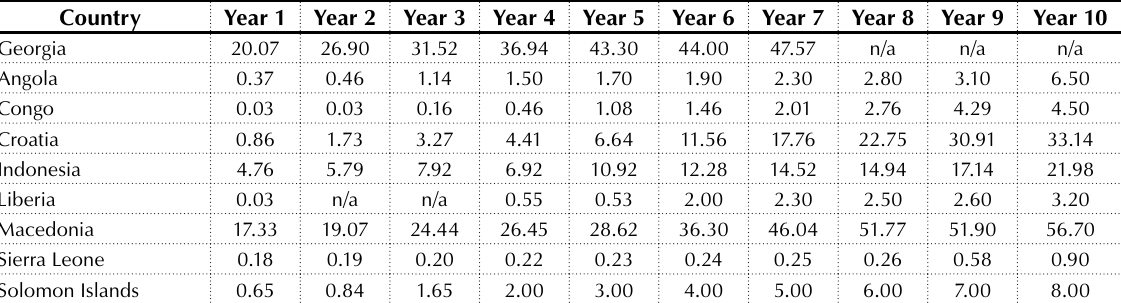
Source: The World Bank Group database.